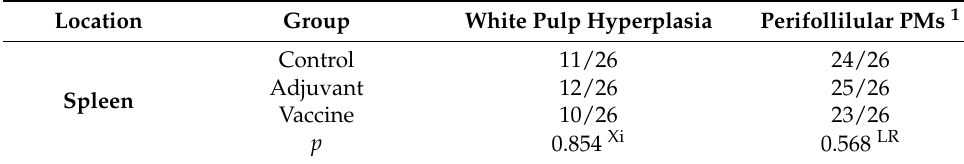
Table A18. Histopathological findings in the spleen.